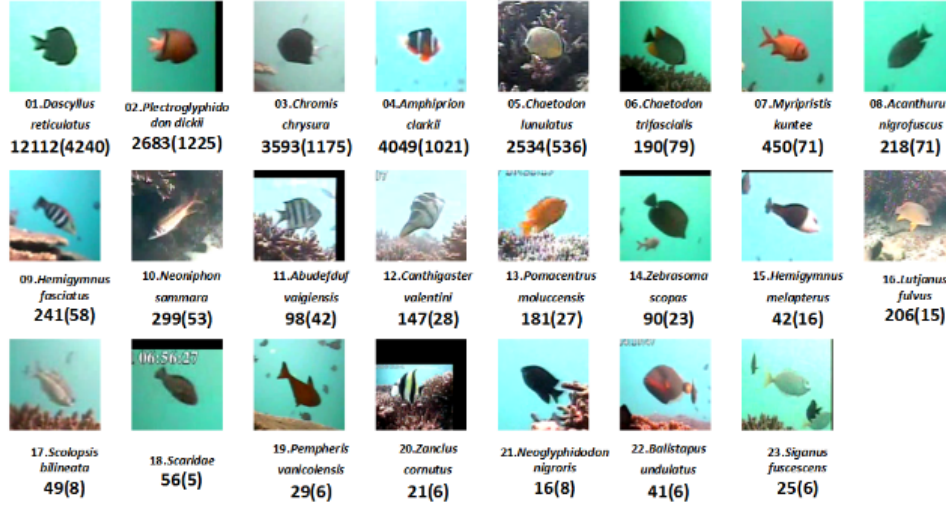
Figure 7. Underwater fish target image data set in ImageCLEF [30]. Table 1. The species used in the dataset.